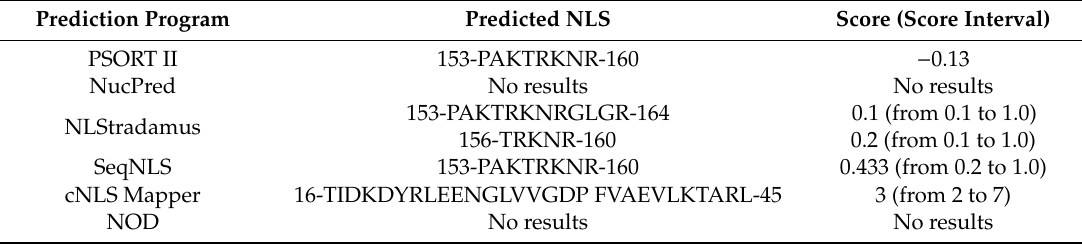
Table 2. Predicted NLS-like motifs in the RrA amino acid